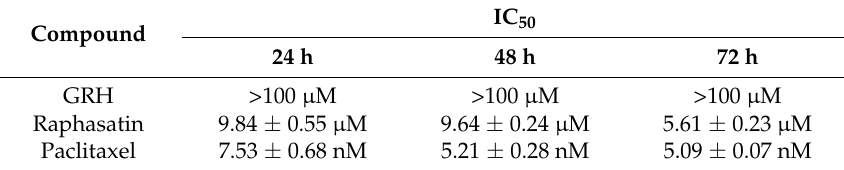
Table 1. Cytotoxicity of GRH, raphasatin, and paclitaxel in human breast adenocarcinoma MCF-7 cells, following incubation for 24, 48, and 72 h, using 3-(4,5-dimethylthiazol-2-yl)-2,5-diphenyltetrazolium bromide (MTT) assay. Data are expressed as mean ± standard deviation (SD) of three independent experiments.